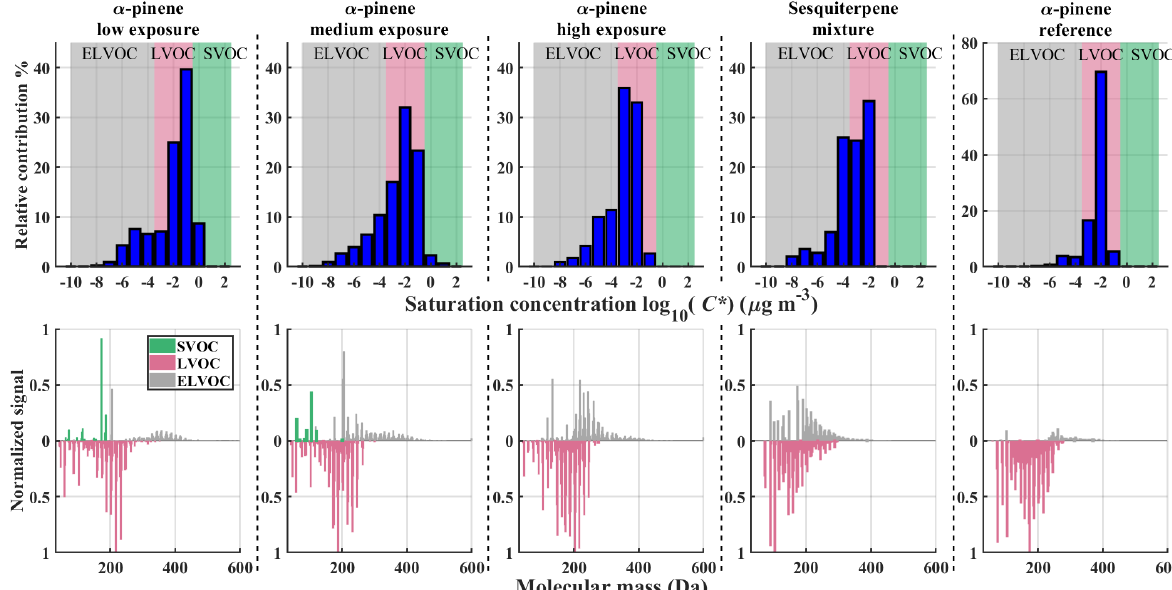
Figure 6. VBS bins and corresponding normalized integrated mass spectra from α -pinene low, medium and high experiment; sesquiterpene mixture; and α -pinene reference experiment. Top row: VBS bins determined from T max with background colours corresponding to different volatility classes (defined in the text). Bottom row: integrated FIGAERO signal normalized to maximum signal and coloured by correspond- ing volatility class. LVOC-class compounds (red) are plotted on an inverted y axis to more easily distinguish them from other volatility classes.